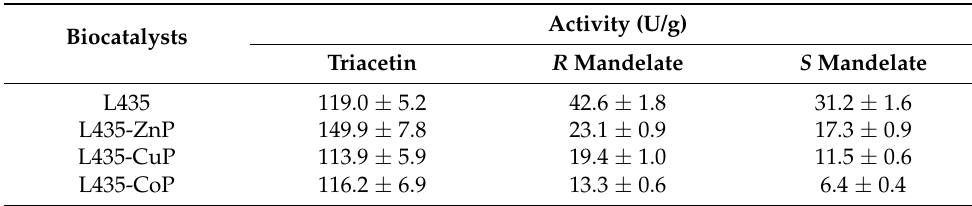
Table 2. Specific activity of different biocatalysts with 50 mM R - or S -methyl mandelate (pH 7, 25 ◦ C) and 50 mM of triacetin (pH 7, 25 ◦ C). Experiments were performed as described in the Methods section.